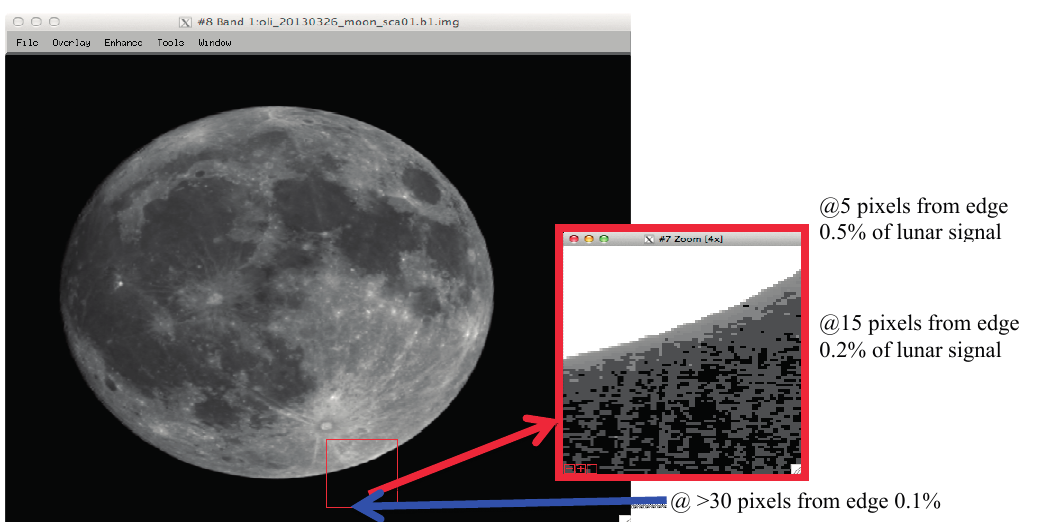
Figure 23. Lunar image with stretched edge response showing that the stray light falls off quickly (image and analysis courtesy of Raviv Levy/GSFC). The signal drops quickly with distance from the Moon